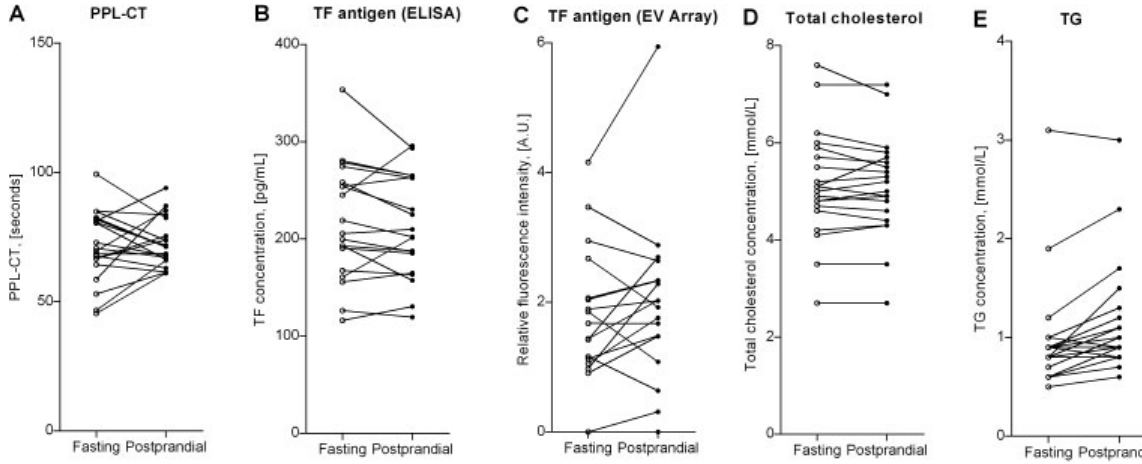
Fig. 5 Fasting and postprandial results on ( A ) procoagulant phospholipid – dependent clotting time (PPL-CT), ( B ) tissue factor antigen (TF Ag) concentration as measured by ELISA, ( C ) TF Ag content as semi-quanti fi ed by EV Array using anti-TF antibodies as both capturing and detecting agent, ( D ) total cholesterol concentration, and ( E ) triglyceride (TG) concentration. Lines combine fasting levels ( open circles ) with postprandial levels ( closed circles ) for each study participant. A.U., arbitrary